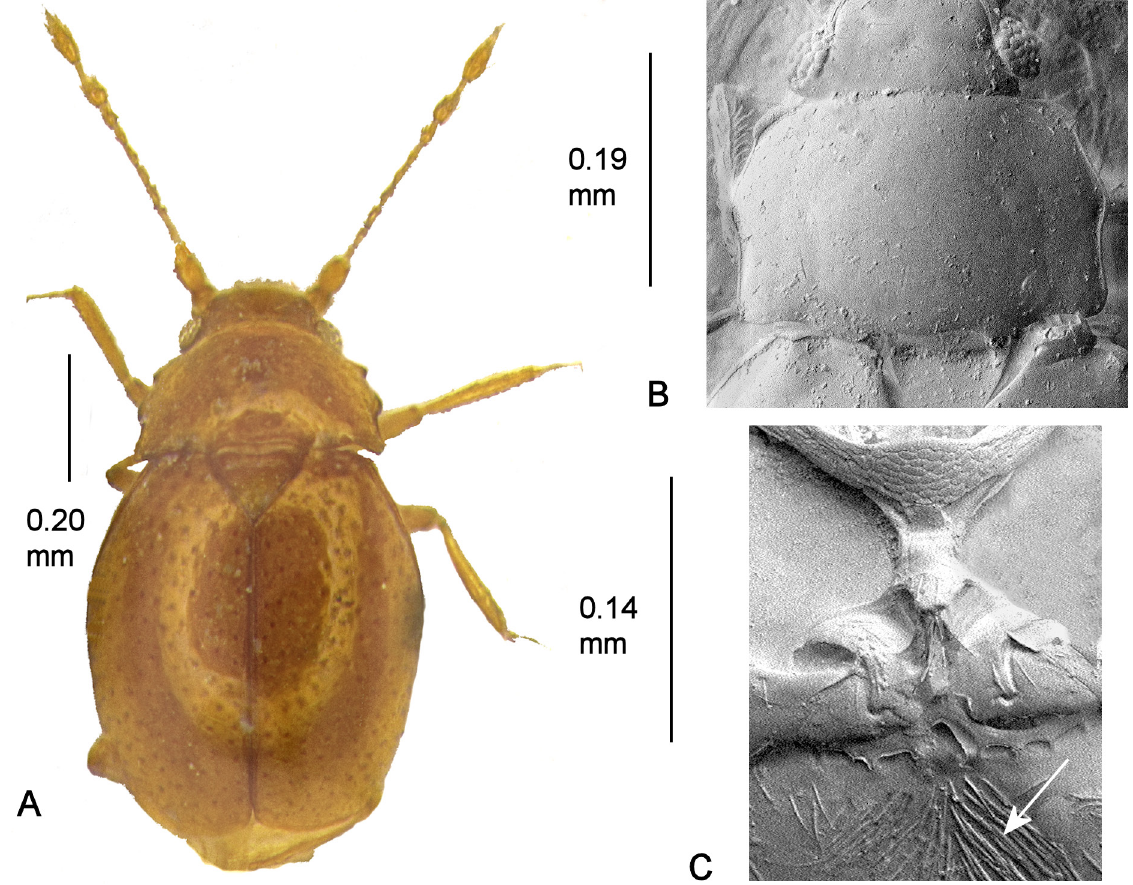
Fig. 90. Cissidium cryptophagoides sp. nov. A . Habitus. B . Pronotum, × 475 C . Mesoventrite showing median process of collar, mid-keel and keel,